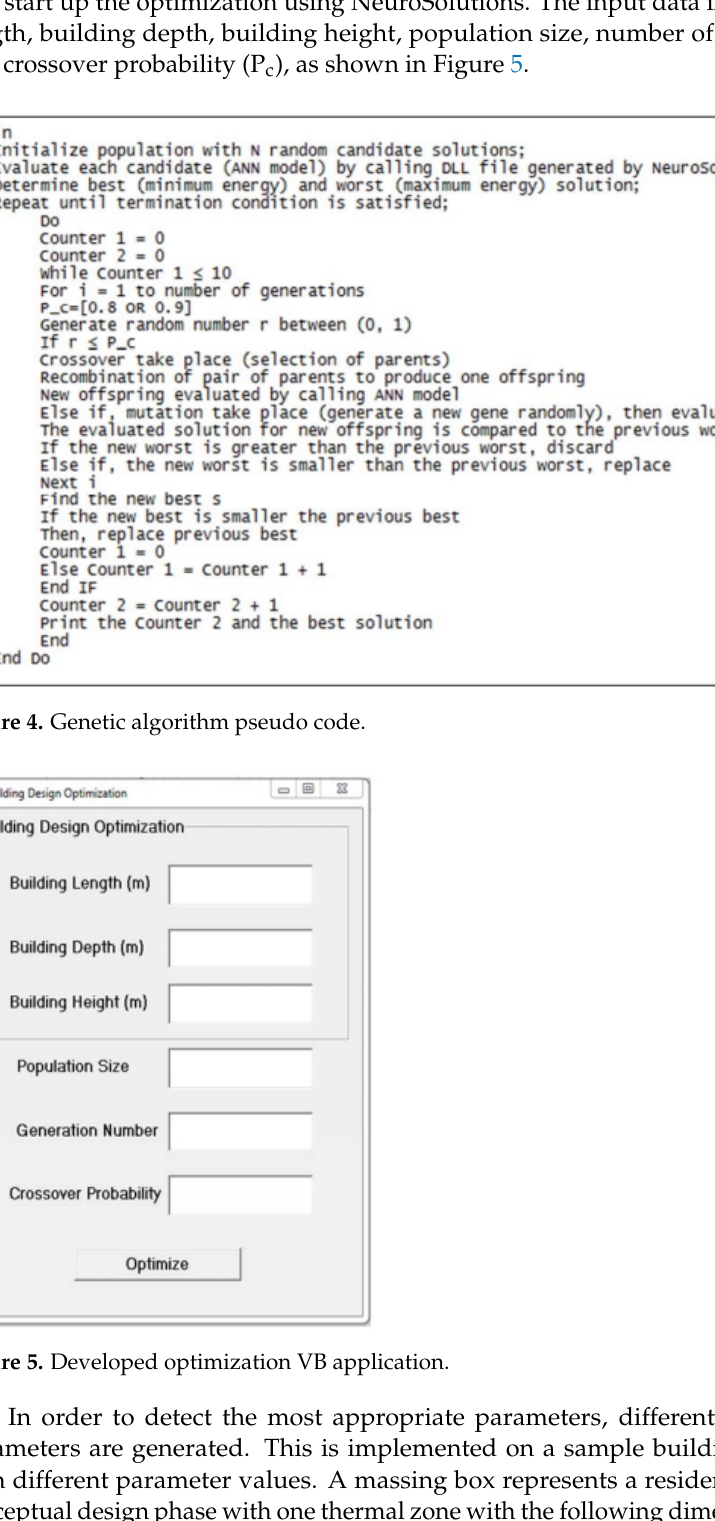
Table 2. Optimization model parameter sets.